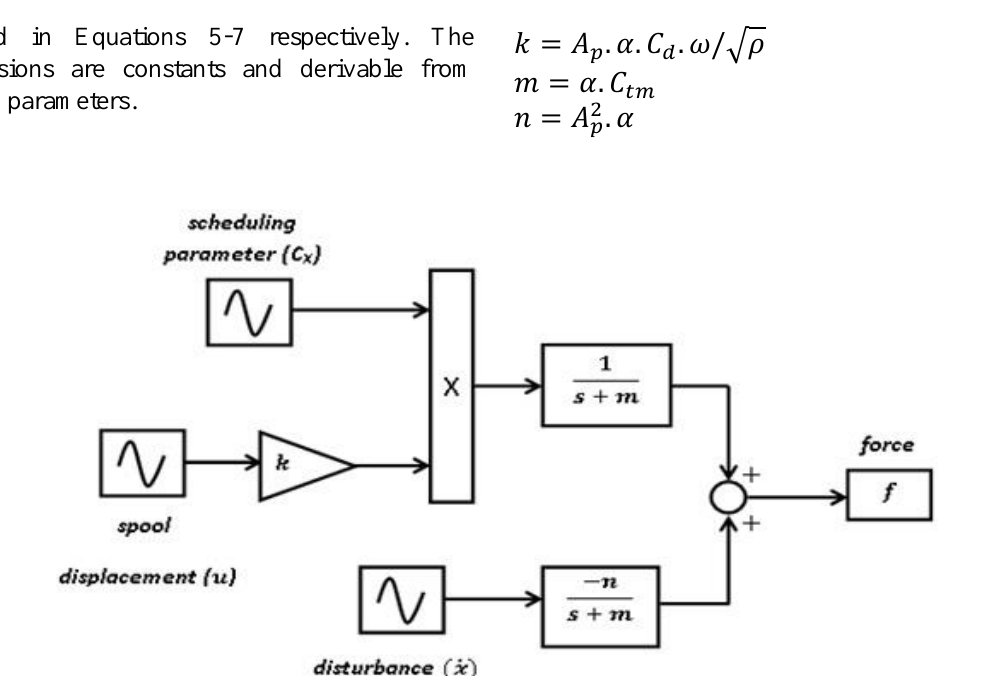
Figure 3. Matlab-Simulink block diagram of the model with gain-scheduling.